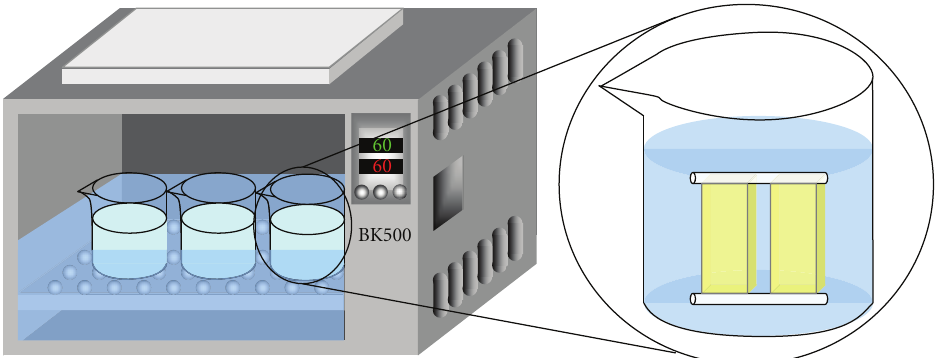
Figure 3: Typical apparatus of immersion